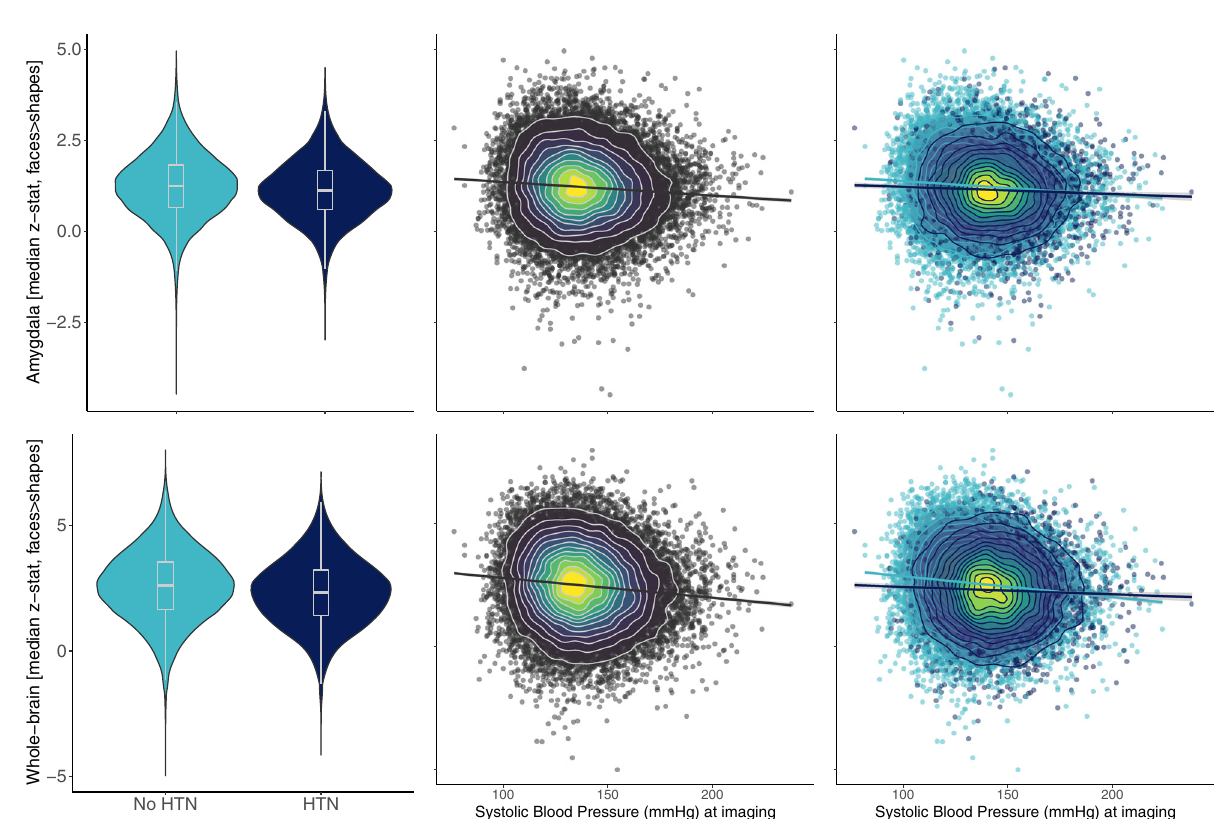
Fig.4|Associationbetweenmentalhealthandsystolicbloodpressureatinitial assessment moderated by hypertension status at follow-up (i.e., approxi- mately10yearslater).A Acrossallparticipants(excludingthosewithHTNanduse of antihypertensives and missing data, N =25,579), systolic blood pressure increased from baseline to follow-up. B People who developed hypertension until follow-up (i.e., received a hypertension diagnosis or started taking anti- hypertensives) until the follow-up assessment (dark blue colour) already showed higher systolic blood pressure levels at initial assessment, despite not having been diagnosed at this timepoint, yet. C No signi fi cant difference between groups in depressive symptoms at baseline (top, N =24,202), but when controlling for SBP, HTN developers showed more depressive symptoms (bottom, N =24,202). D No